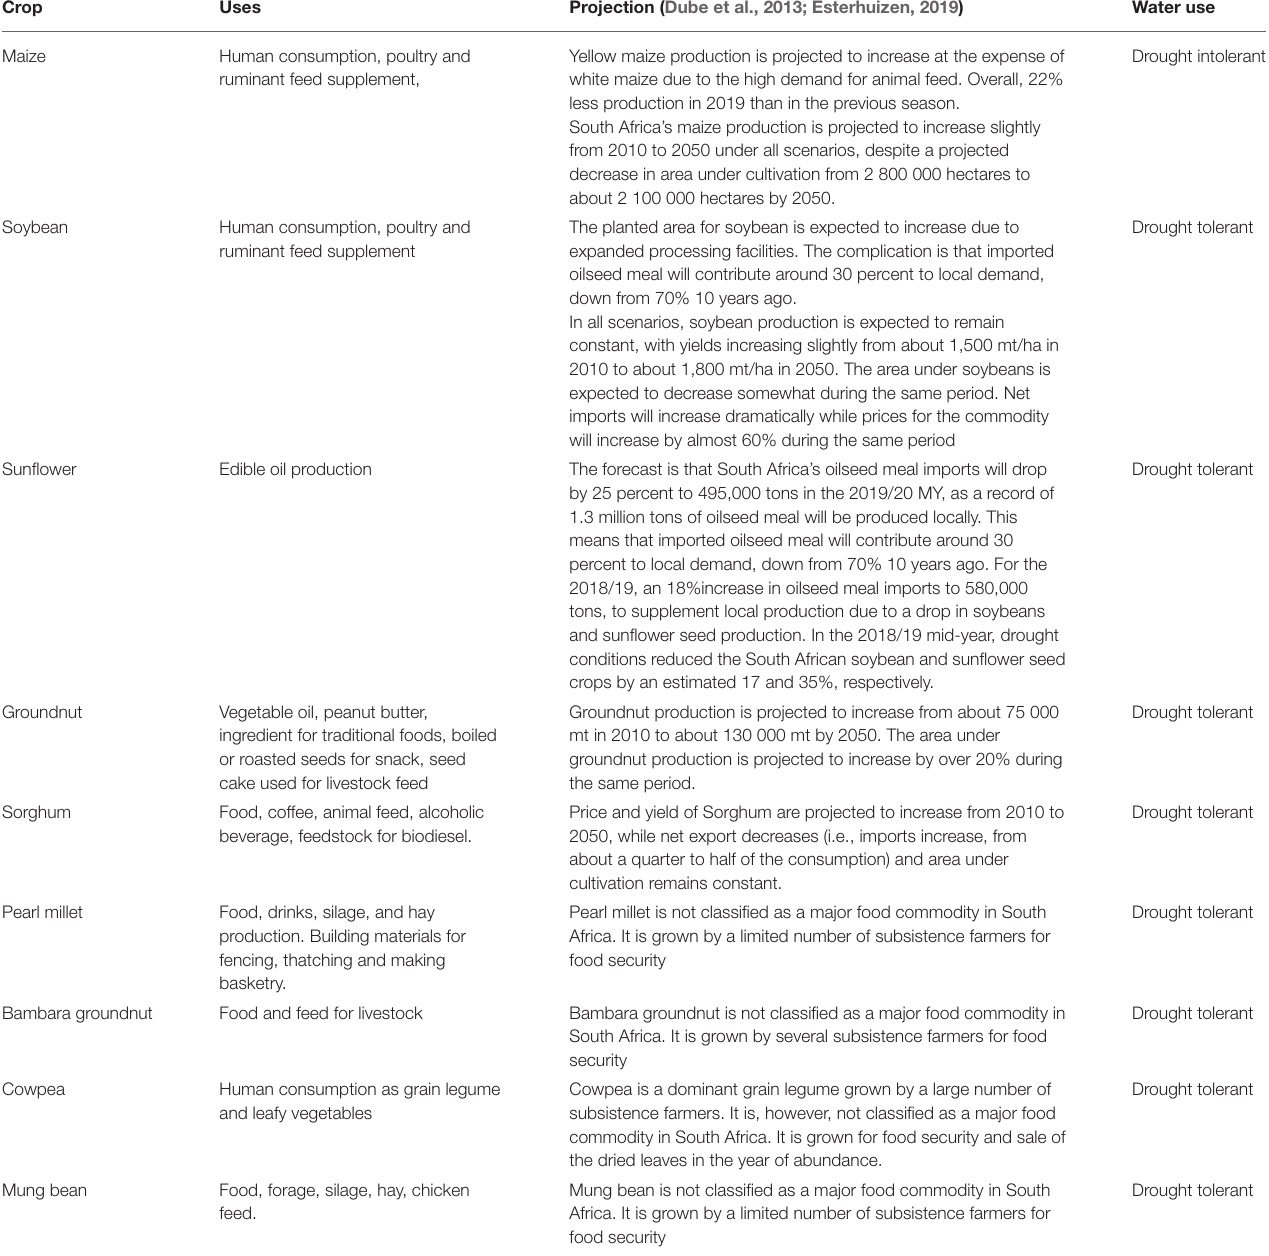
TABLE 7 | Grain crop uses. Crop Uses Projection (Dube et al., 2013; Esterhuizen, 2019) Water use